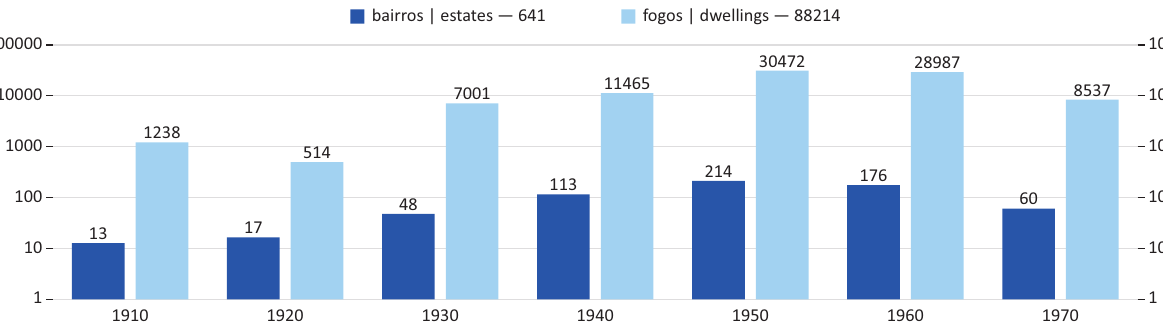
Figure 4. Linear chart with information about the number of dwellings built in each programme. Note: The universe is composed of built estates and dwellings built between 1910 and 1974, included in the MdH database. Source: Ramos, Gonçalves, et al.